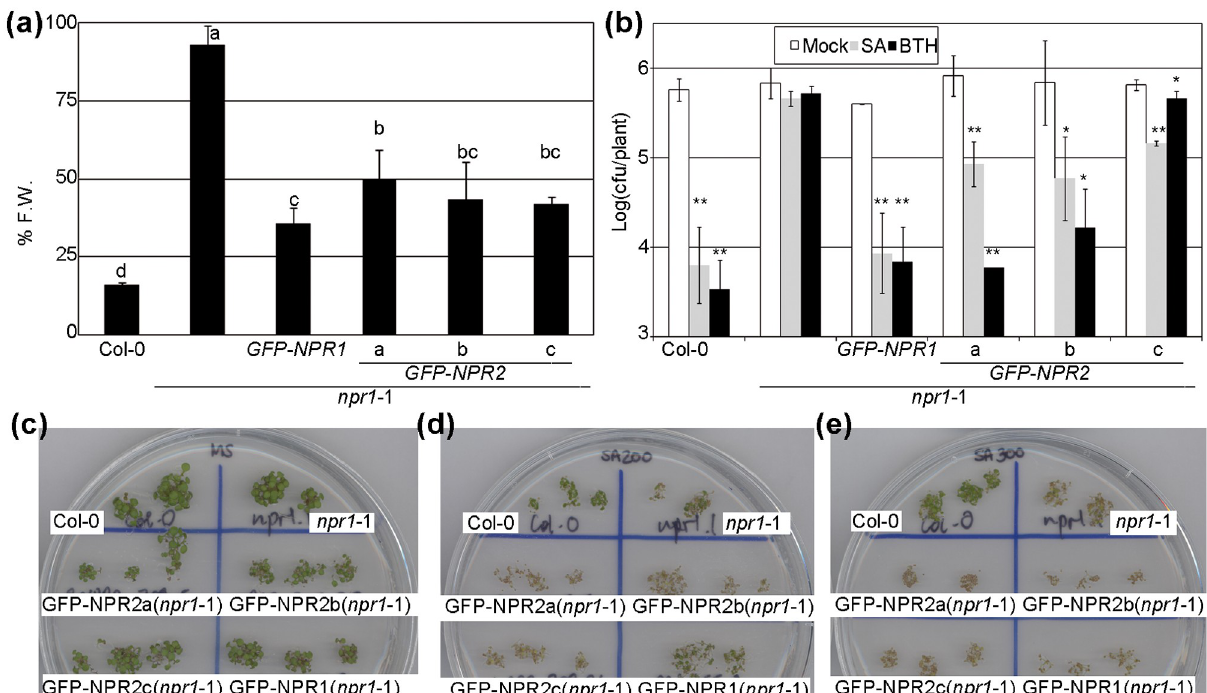
Fig 1. NPR2 complements npr1-1 in Arabidopsis. (a) Homozygous transgenic plants 35S : GFP-NPR2 of Arabidopsis in an npr1-1 background were tested for their response to benzothiadizole (BTH, an analogue of SA), along with control genotypes. The response to BTH was measured as weight, and plants were treated with either mock or 350 μ M BTH. The ratio is expressed as percentage of fresh weight (%FW). The letters above the bars indicate different homogeneous groups with statistically significant differences (Fisher’s LSD Test, P < 0.05). In all the figures that give numerical information, the data represent the average, with the error bars plotting the standard deviation. All the experiments were repeated at least three times with similar results. (b) The indicated genotypes (14-day-old plants) were treated with either 1 mM SA, 350 μ M BTH or a mock solution. One day later the plants were inoculated with Pseudomonas syringae pv. tomato isolate DC3000 ( Pto ) at 5 � 10 7 colony forming units (cfu) per mL. Three days after inoculation, the growth of Pto was evaluated as the Logarithm of cfu per plant. Asterisks indicate statistically significant differences from the mock treatment in each genotype (P < 0.05 one asterisk, P < 0.01 two) using the Student’s t test (one tail). (c) The indicated genotypes were grown on MS plates, and the picture was taken at day 7 after germination. (d) The same experiment as in (a), with 200 μ M SA. (e) The same experiment as in (a), with 300 μ M